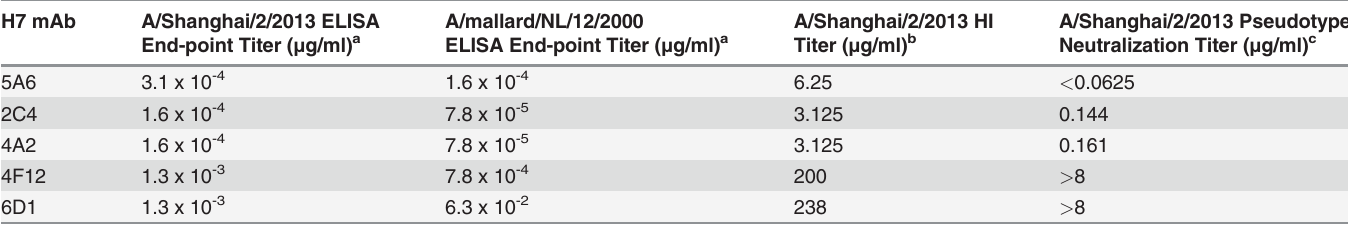
Table 1. Characterization of H7 A/Shanghai/2/2013 monoclonal antibodies. H7